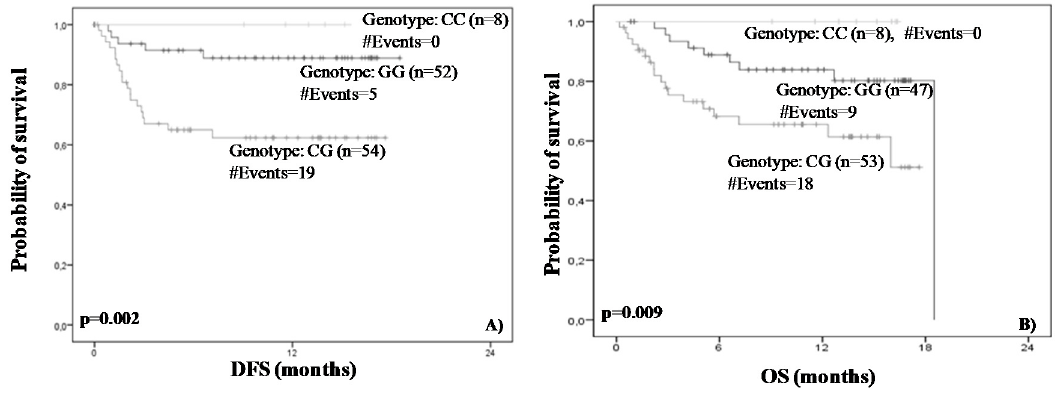
Figure 4. Kaplan–Meier disease-free ( A ) and overall ( B ) survival curves. p values were calculated by log-rank test.